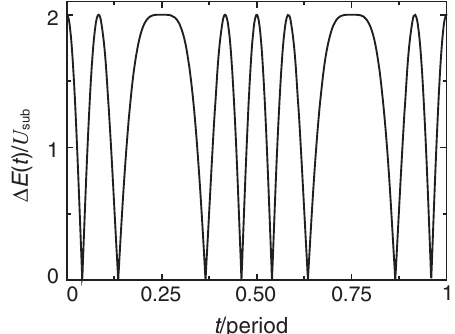
FIG. 3. Variation of potential energy barriers separating the neighboring minima in the particle-substrate energy landscape with time during one period of oscillations with the amplitude equal to A ¼ 2 a . The results are for commensurate